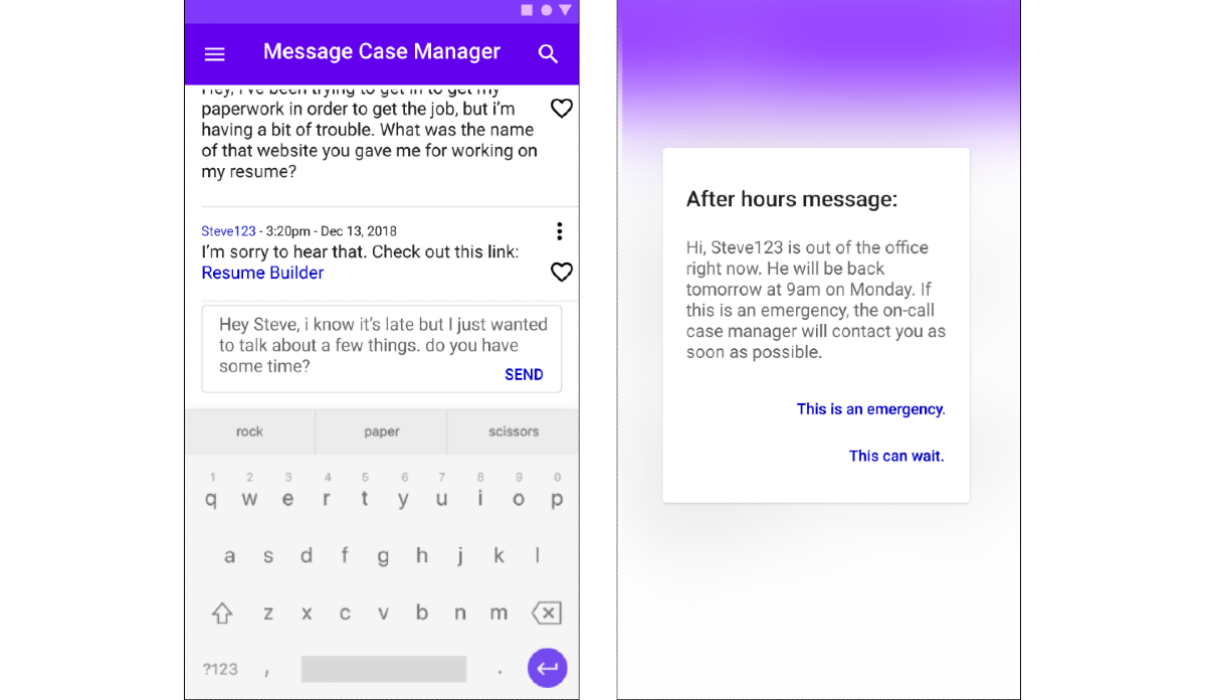
Figure 3. Proposed depiction of a mobile application wireframe showing a conversation between a case manager and client. In this particular case,